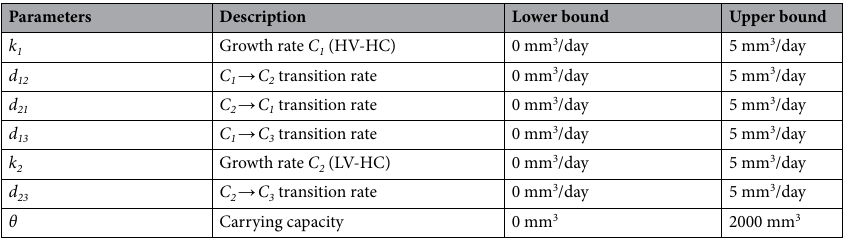
Table 1. Parent model parameters and the bounds used in nonlinear fitting for model calibration. All growth rates, k n , and transition rates, d nm , are in units of mm 3 /day, and the carrying capacity, θ , is in units of mm 3 . The upper bound of the carrying capacity, θ, was chosen based on the known approximate volume of a rat’s brain. Upper bounds for all rates were chosen based on empirical growth rates of the tumors observed in the imaging